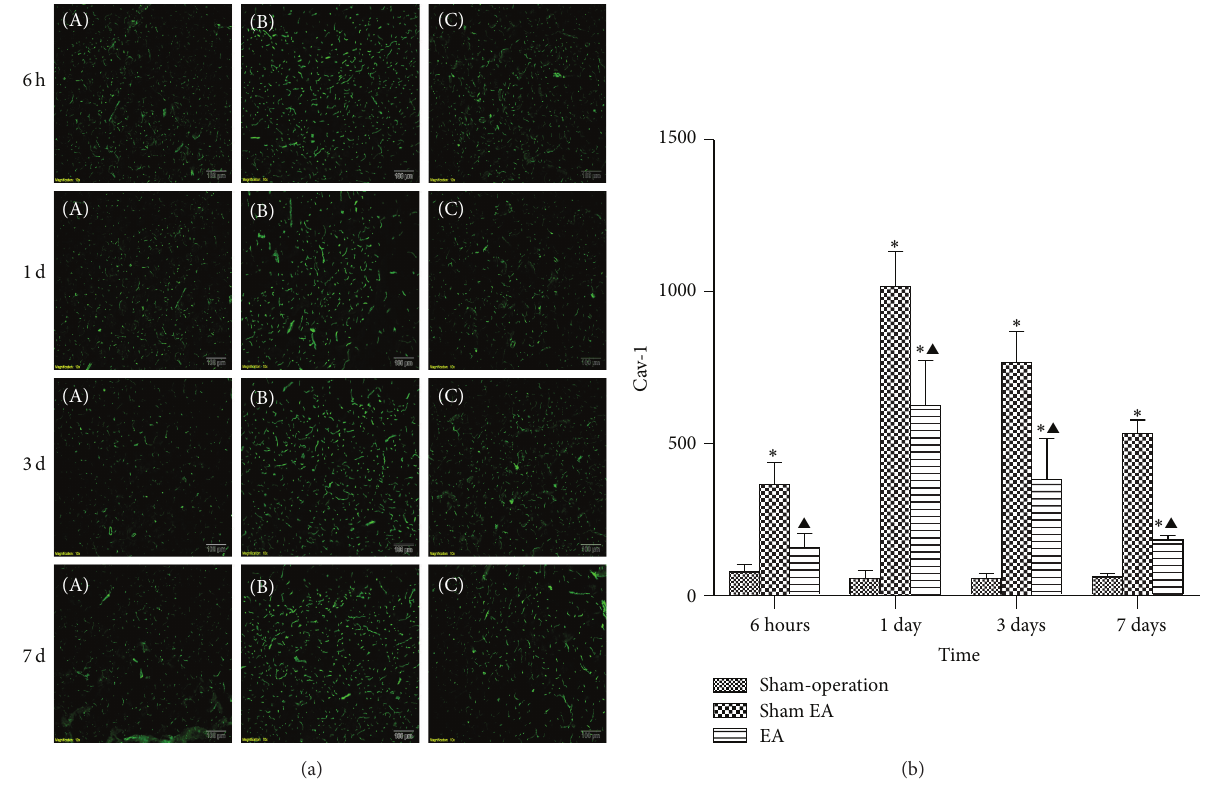
Figure 3: Effects of EA on the in situ expression of Cav-1 after ICH in rats (mean ± SD, 𝑛 = 6 ). (a) Expression of Cav-1 in focal rat brain coronal frozen sections. (A) Sham-operation group; (B) Sham EA group; (C) ICH plus EA group. (b) Quantitative analysis for the results of groups at 6h, 24 h, 3 d, and 7 d, respectively. One-way analysis of variance (ANOVA) was used for multiple group experiments comparisons and followed by Dunnett test for comparison of two groups within the multiple groups. ∗ 𝑃 < 0.05 , compared with Sham-operated group. 󳵳 𝑃 < 0.05 compared with Sham EA